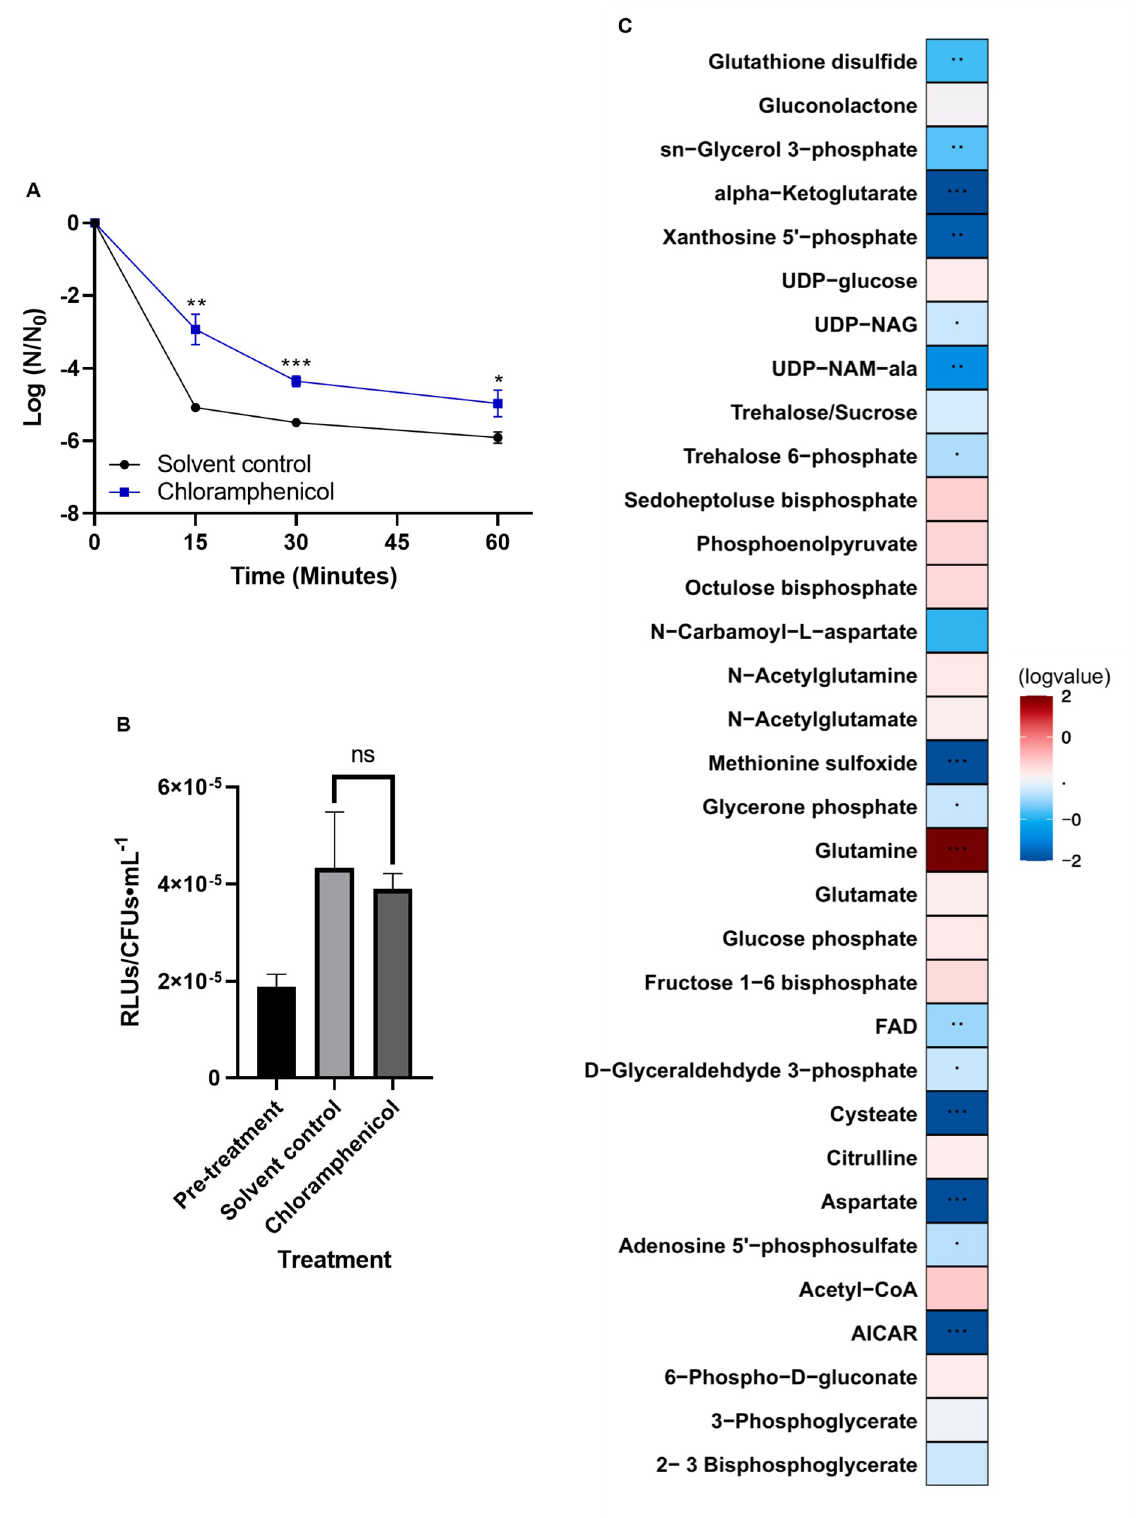
Fig 3. Chloramphenicol-treated cells have increased tolerance to daptomycin and an altered metabolic profile. (A) Cells were grown to an OD 600 of ~0.250 and treated for 30 min with chloramphenicol or solvent control, washed with 1xPBS, and then exposed to 30 μ g/mL